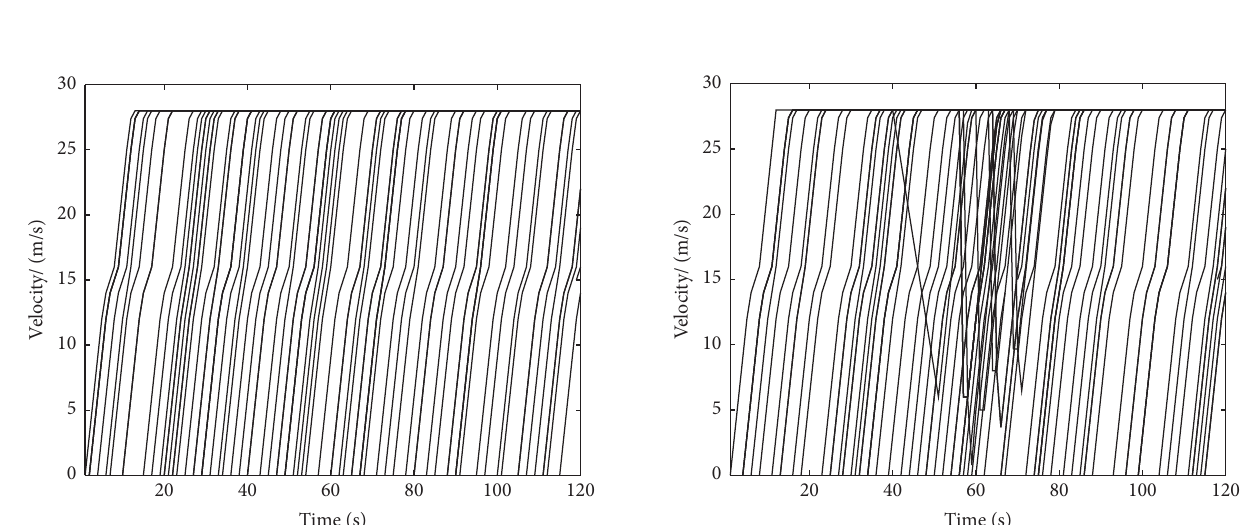
Figure 6: Velocities without merging vehicles.